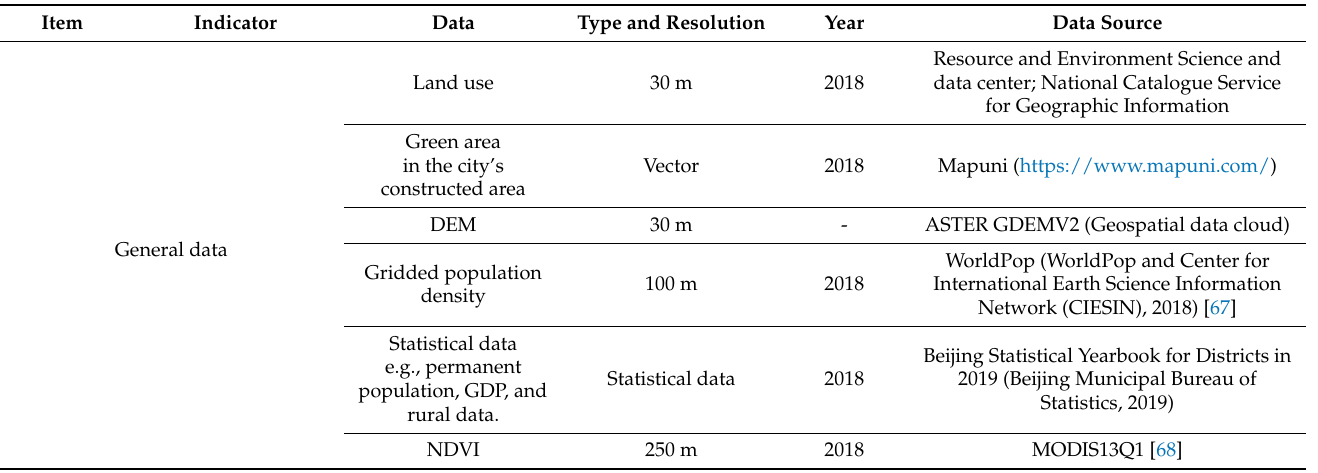
Figure 2. The land use map of the study area. Multi-source data are used in this study, including spatial data, literature data and statistical data, as shown detailed in Table 1. Table 1. Data